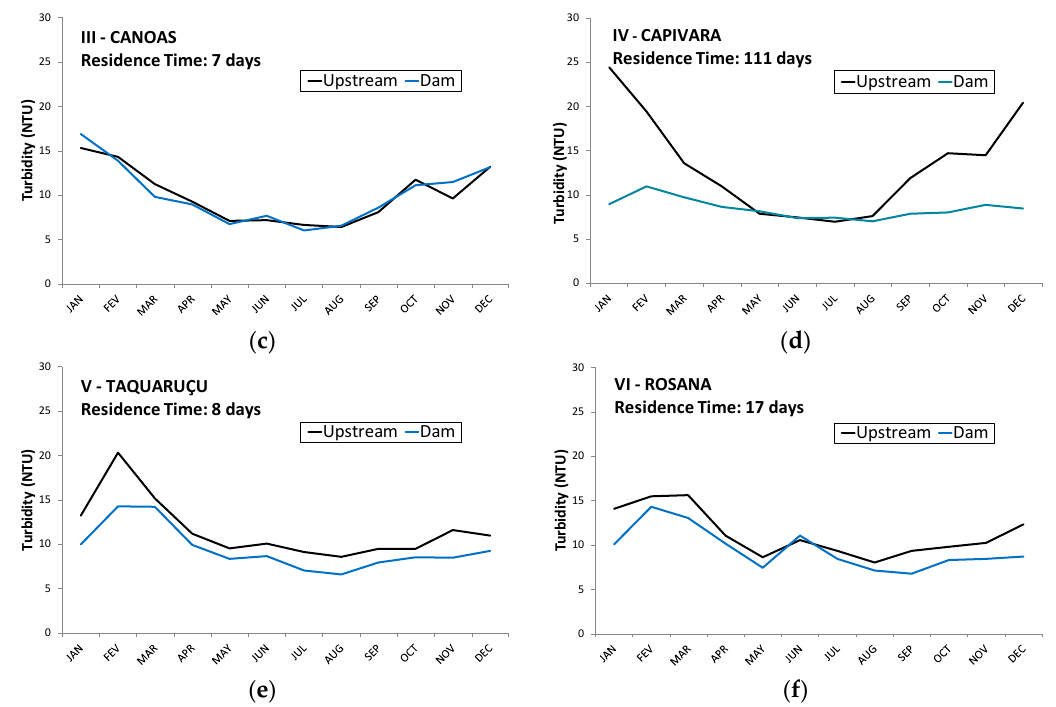
Figure 8. Monthly longitudinal remote sensing-based turbidity variation (2000–2013) in the hydropower reservoirs of the Paranapanema River. Table 3. The mean, minimum and maximum turbidity calculated for all of the reservoirs. Position